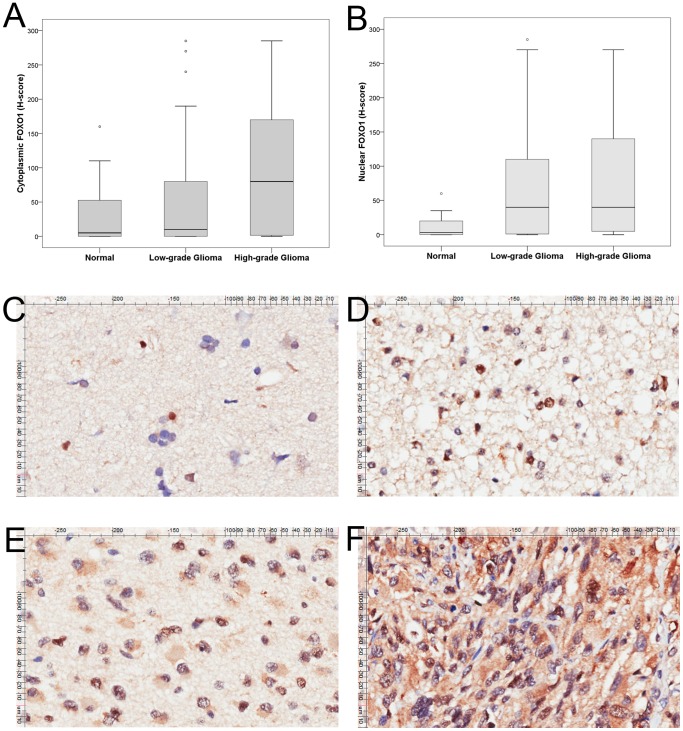
Tissue microarray analysis of FOXO1 expression.(A, B) Cytoplasmic and nuclear FOXO1 expressions were higher in astrocytomas than in normal brain tissues. High-grade gliomas express more cytoplasmic FOXO1 than low-grade gliomas while nuclear FOXO1 expression was comparable in both. The horizontal line inside the box represents the median. The outliers are cases with the values between 1.5 and 3 box-lengths from the 75th percentile or 25th percentile. Representative images of FOXO1 expression in normal brain tissue (C, ×200); grade II diffuse astrocytoma (D, ×200); grade III anaplastic astrocytoma (E, ×200) and grade IV glioblastoma (F, ×200).